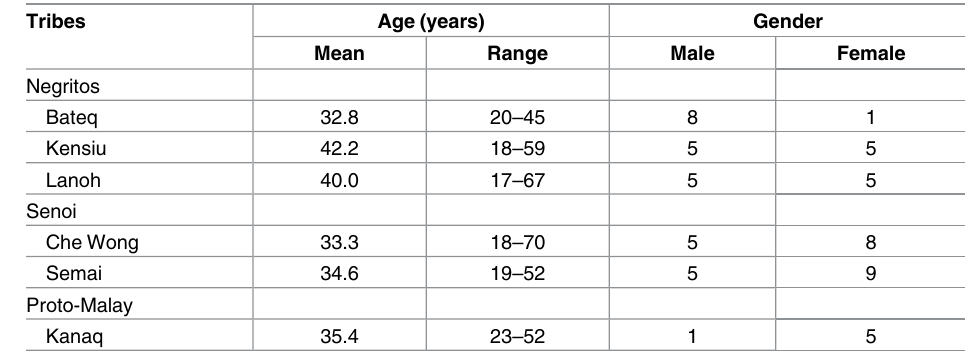
Table 1. Demographic data of the Orang